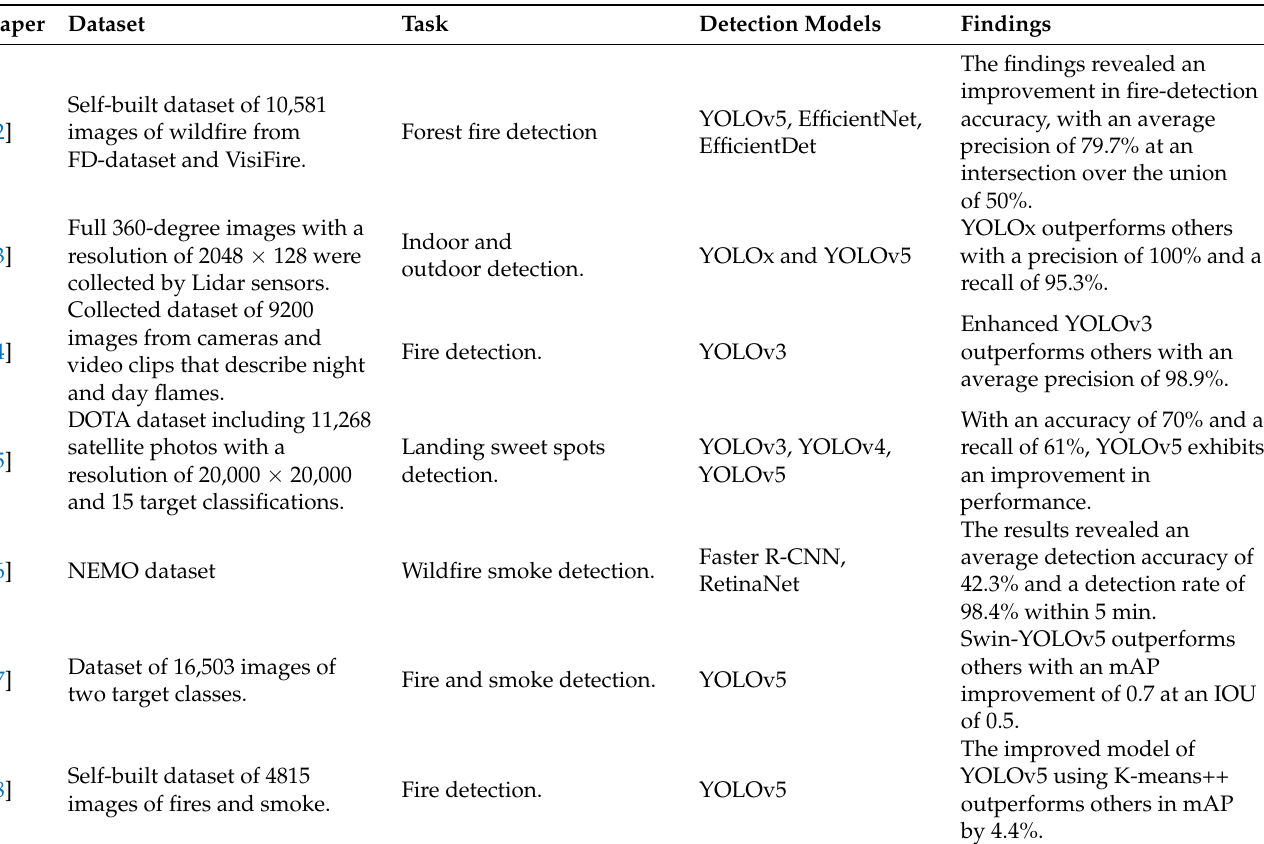
Table 1. Summary of related state-of-the-art